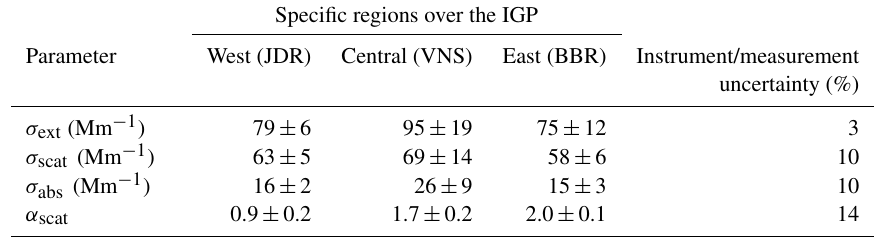
Table 2. Mean ± standard error of column-averaged (from near the ground to 3000m) aerosol radiative properties. Specific regions over the IGP